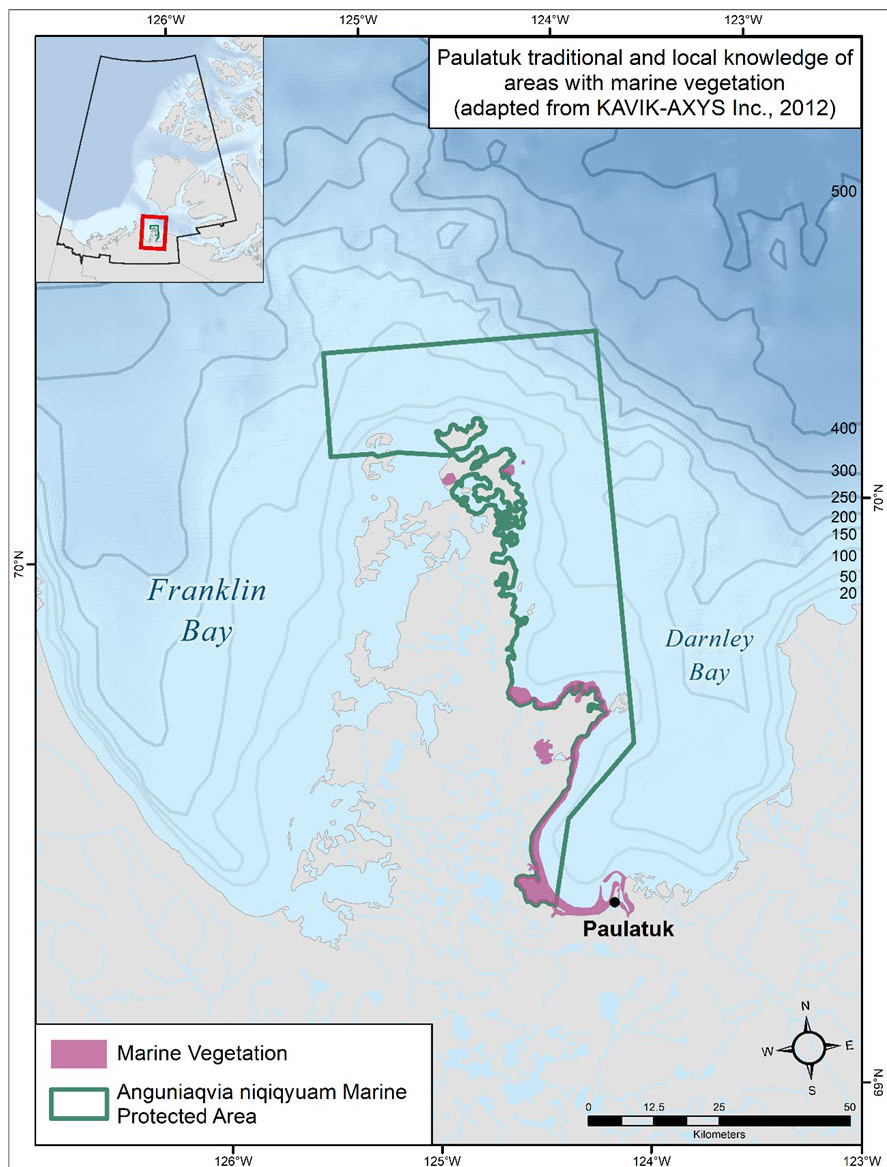
Figure 11. Locations of marine vegetation in the vicinity of the ANMPA from traditional and local knowledge gathered during a workshop in Paulatuk in 2011. Map adapted from KAVIK-AXYS Inc. (2012) by J. Friesen and provided by the ANMPA Working